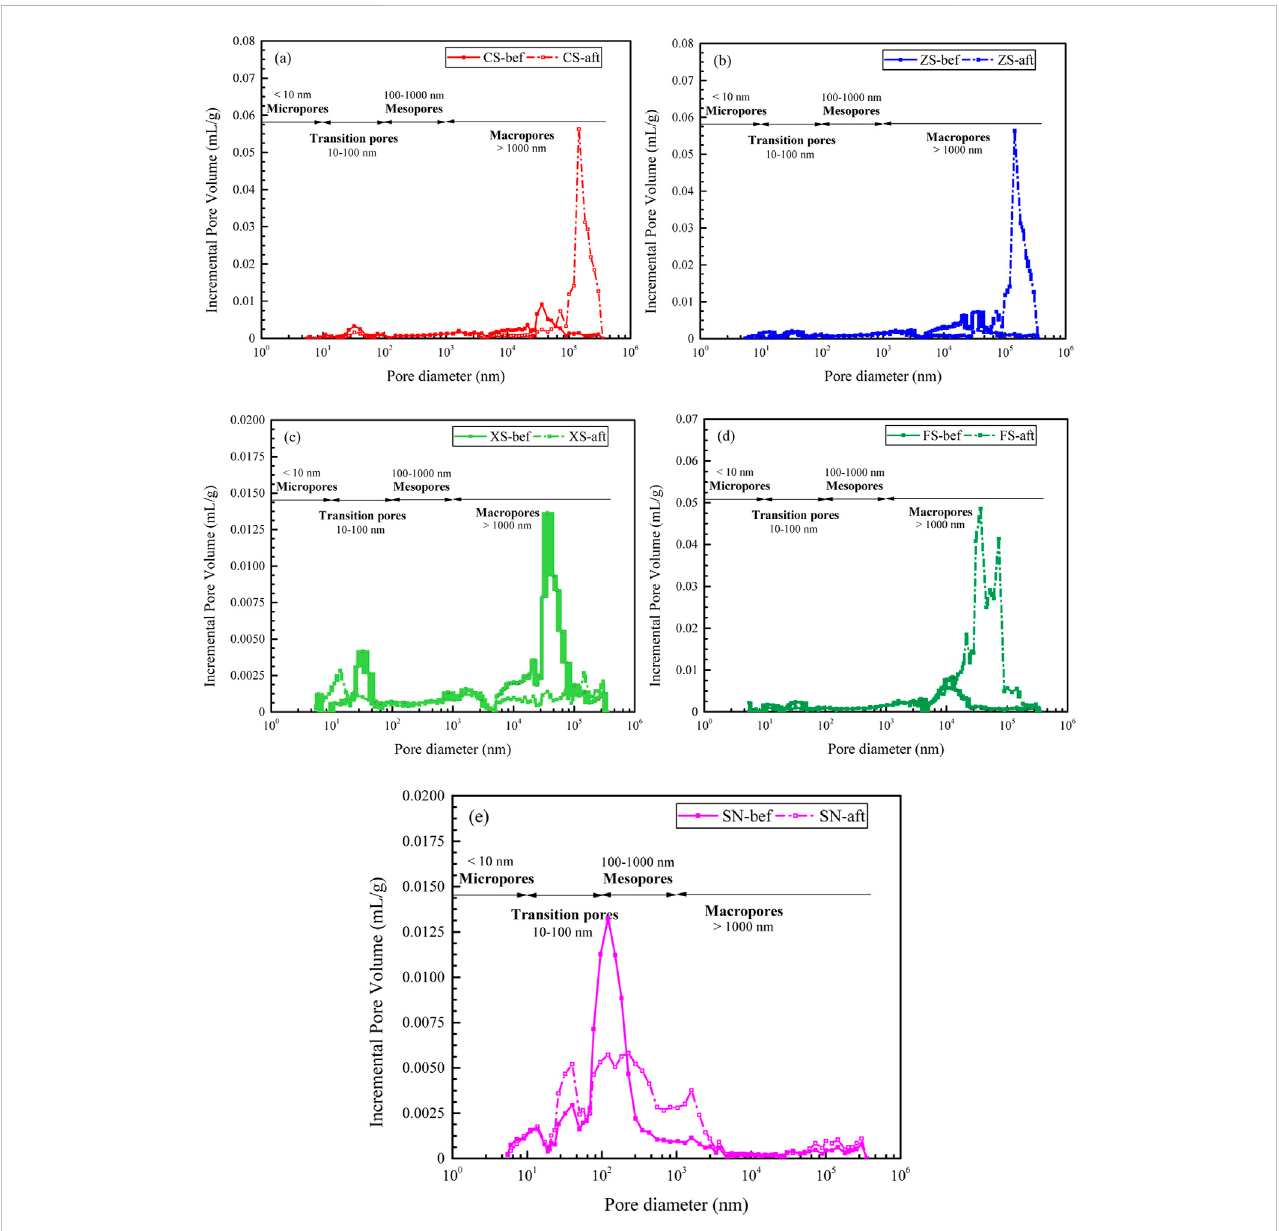
FIGURE 6 Pore distribution characteristics of samples: (A – E) represent the samples CS, ZS, XS, FS, and SN.